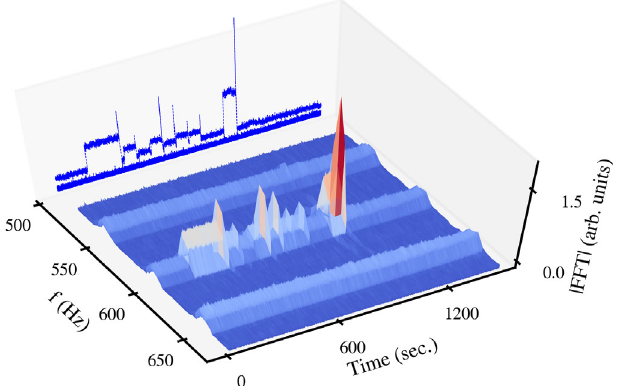
FIG. 13. The horizontal spectrogram of Beam 1 during the tests of the active filters at injection centered around 600 Hz. The blue lines represent the amplitude evolution of the spectral compo- nents in this regime.